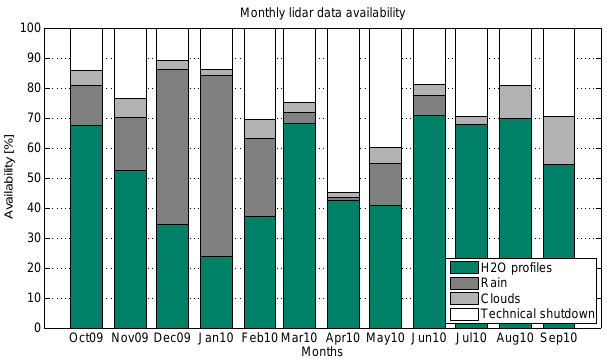
Fig. 2. Lidar data availability for the period 1 October 2009 to 30 September 2010. Green bars represent the percentage of time when the lidar is producing humidity profiles. Grey bars represent the percentage of time when the lidar is in stand-by mode due to either rain or low clouds. White bars represent the percentage of time when the lidar is off due to maintenance or technical problems.